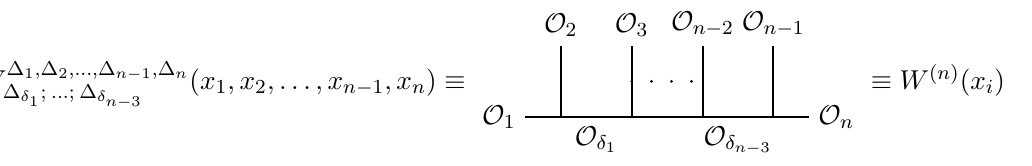
Figure 1 . The comb channel n -point global conformal block for external scalar oper- ators O 1 ( x 1 ) ; : : : ; O n ( x n ) with conformal dimensions (cid:1) 1 ; : : : ; (cid:1) n and insertion